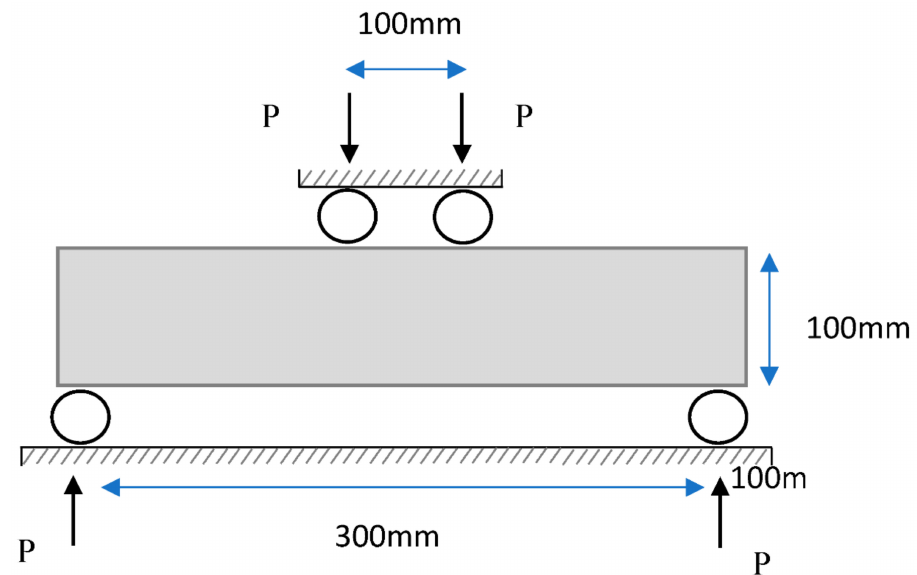
Figure 3. Schematic illustration of four-point bend test.